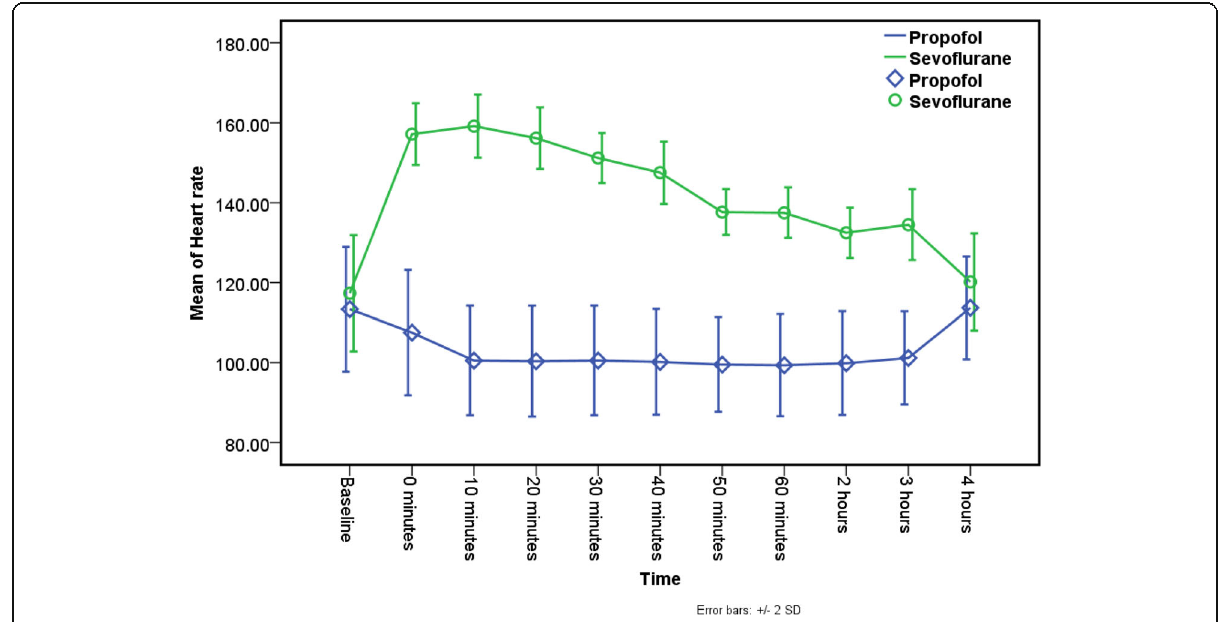
Fig. 2 Changes in mean heart rate from baseline up to 4 h postoperative in the two studied groups. A P value < 0.05 was considered